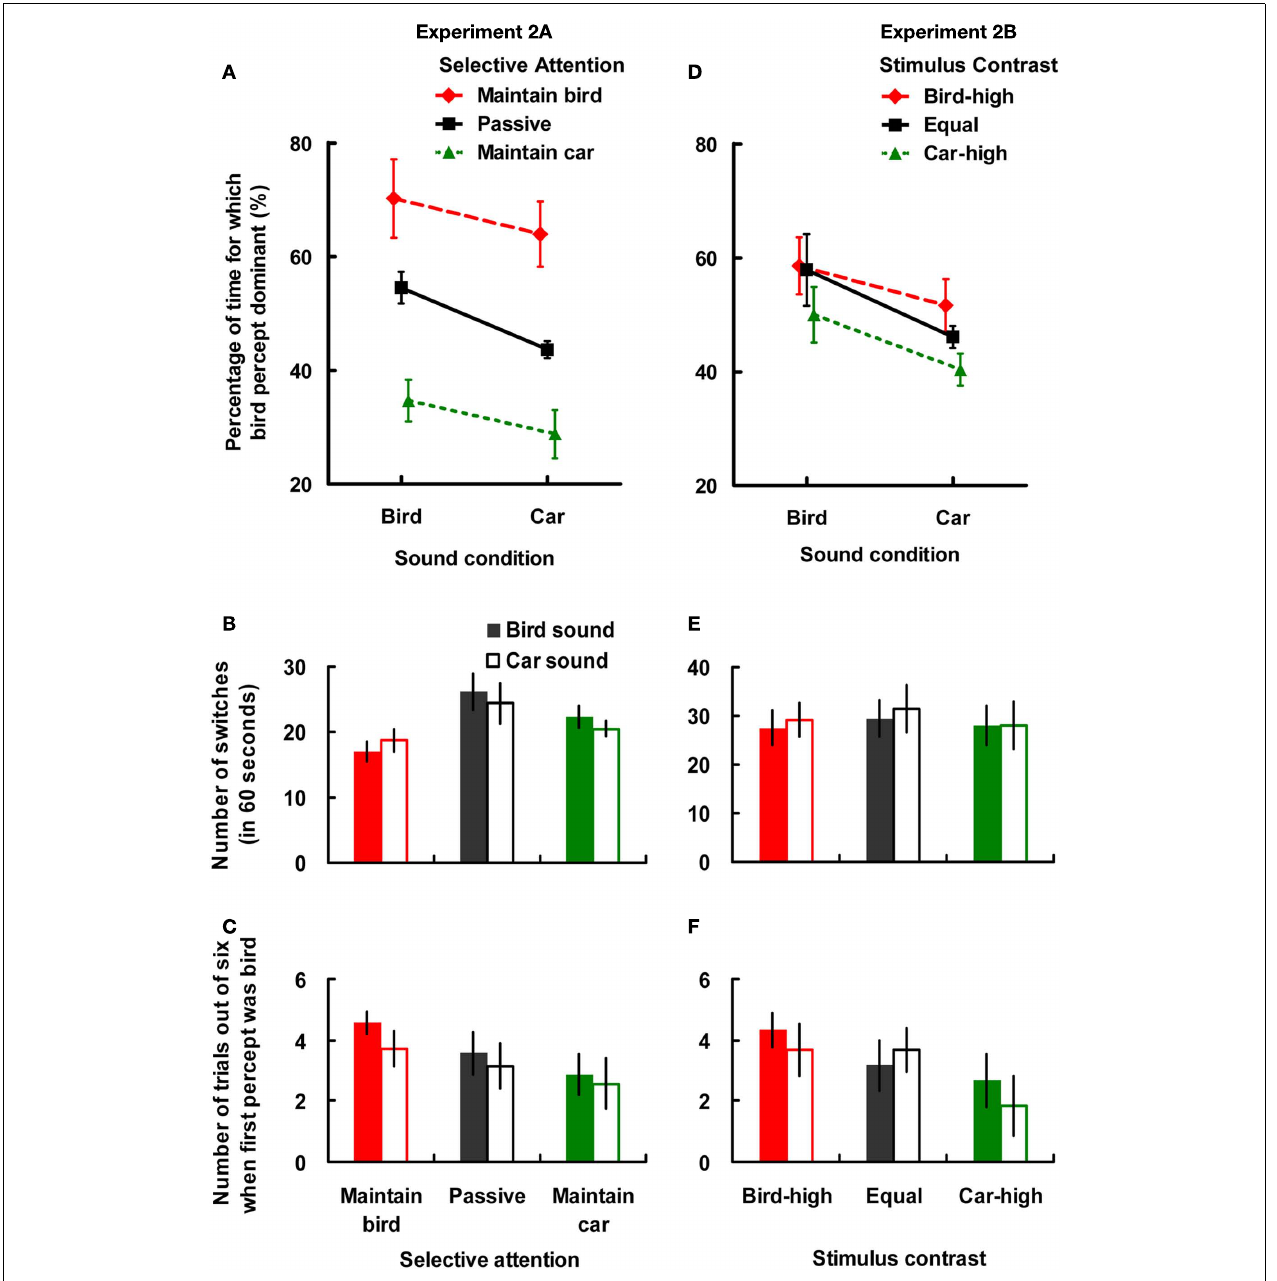
panels (C,F) show the number of times that participants reported the bird as the first percept (out of six trials). (A) The proportion of time that the bird percept was dominant in the maintain bird (dashed line), passive viewing (solid line), and maintain car (dotted line) conditions of Experiment 2A. (D) The proportion of time that the bird percept was dominant in the bird-high (dashed line), equal (solid line), and car-high (dotted line) conditions in Experiment 2B. Error bars represent ± 1 SE of the